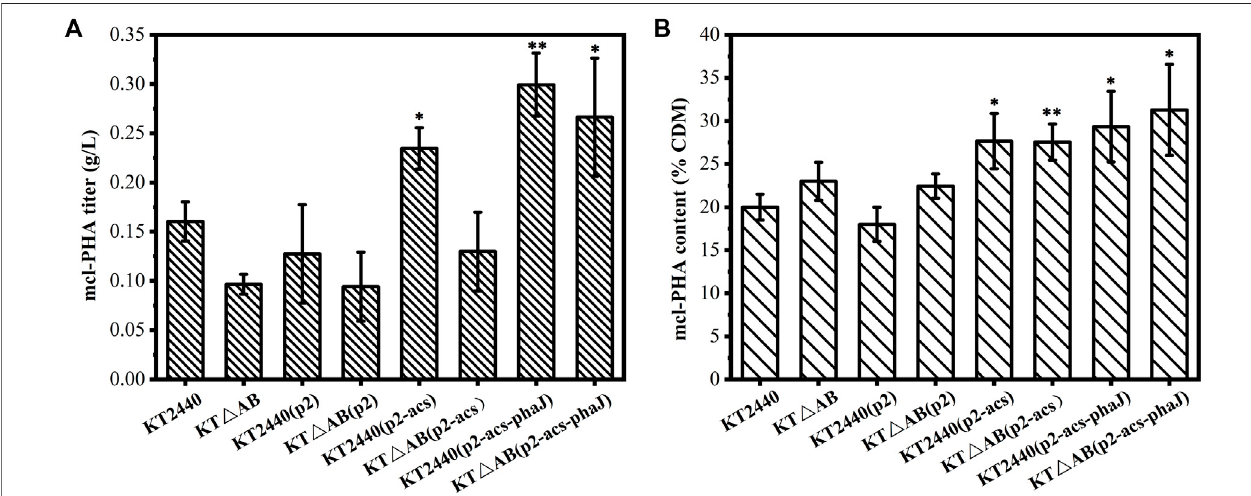
FIGURE 4 | Comparison of the production of mcl-PHA by engineered P. putida in shake- fl ask fermentation with acetic acid as the sole carbon source, and the cultivation time was 60 h (A) The titer of mcl-PHA (B) Intracellular content ofmcl-PHA. The error bars indicate the standard deviation of triplicate experiments. * p < 0.05; ** p < 0.01; *** p < 0.001; ns, no signi fi